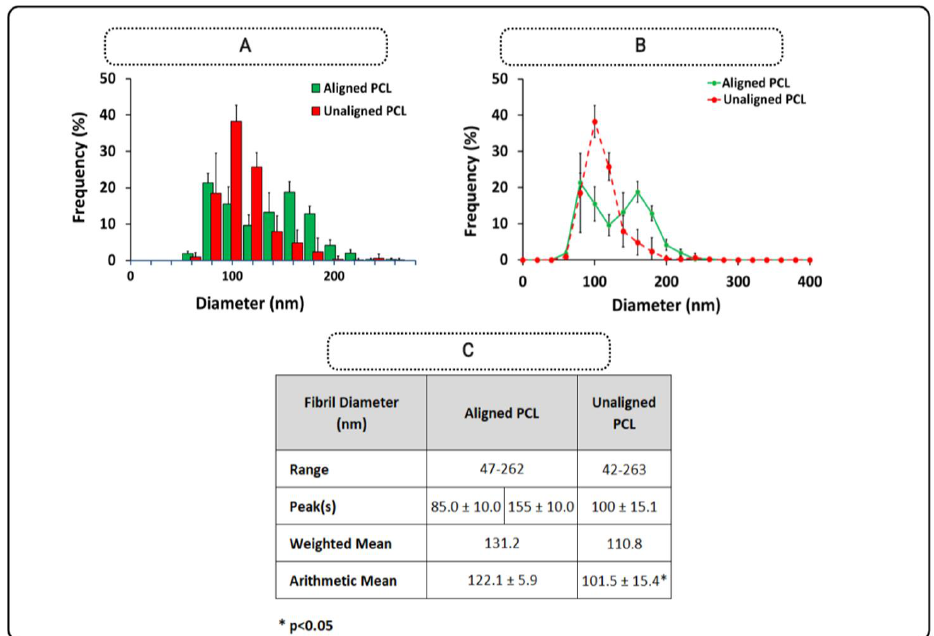
Figure 5. Aligned and unaligned PCL fiber diameter distributions. ( A ) Histogram, ( B ) line graph, and ( C ) descriptive statistics. * shows a significant difference at p < 0.05 ( n = 4), and error bars represent standard deviation.